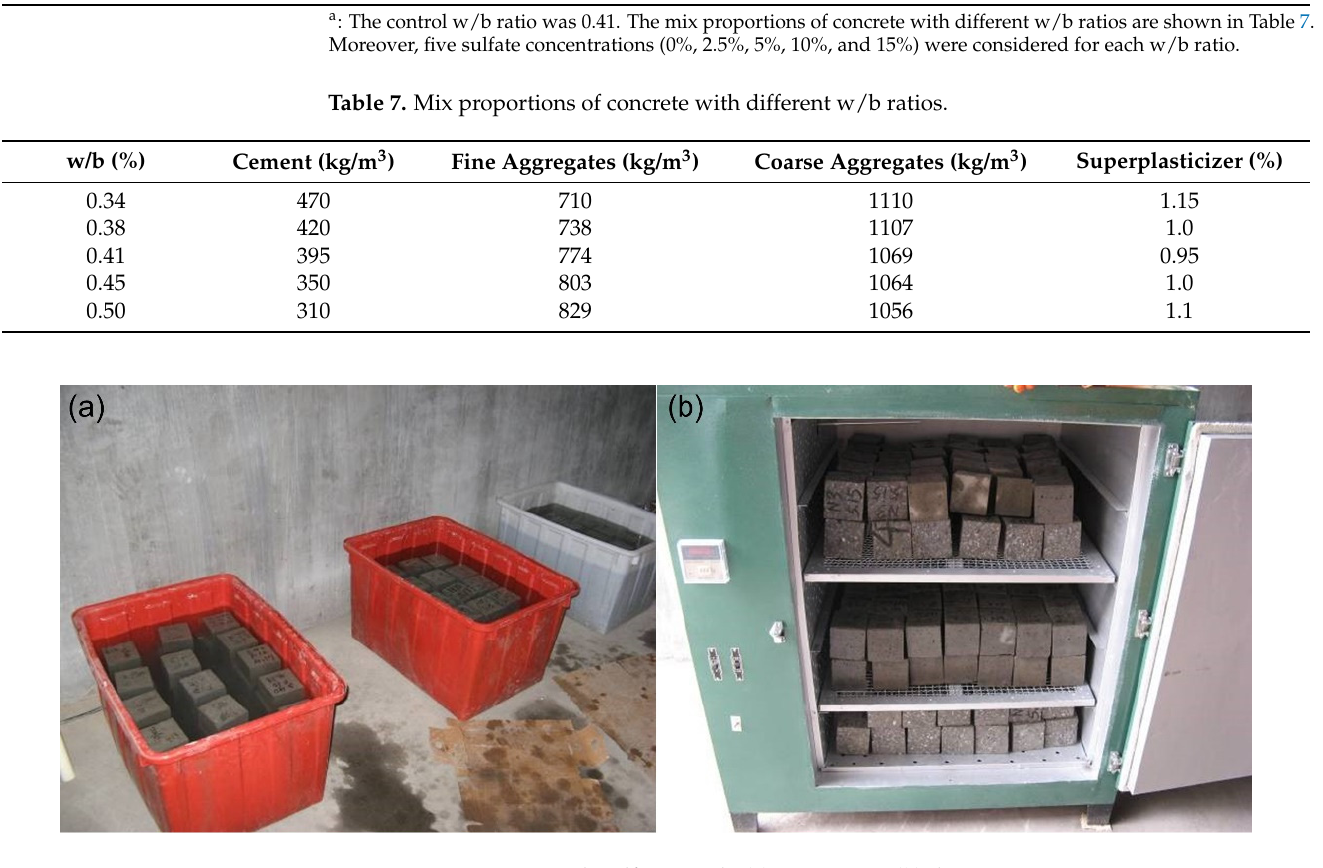
Table 7. Mix proportions of concrete with different w/b ratios.